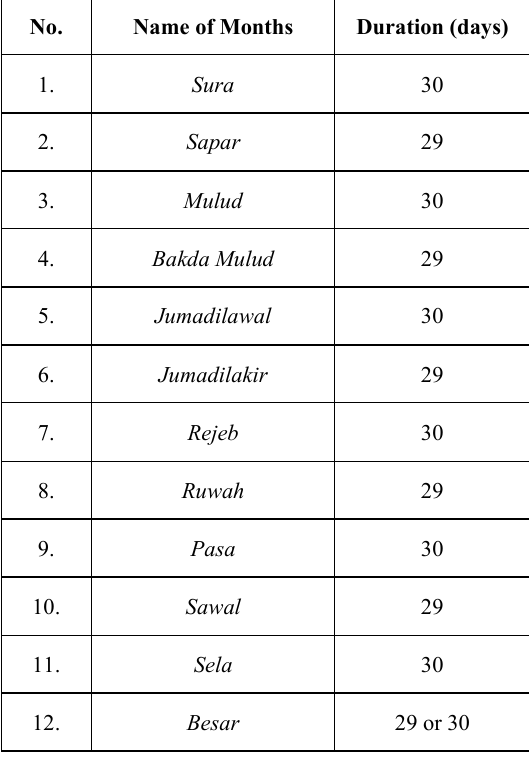
Table 1. The Name of Months in the Moon Javanese Calendar and their Duration. No. Name of